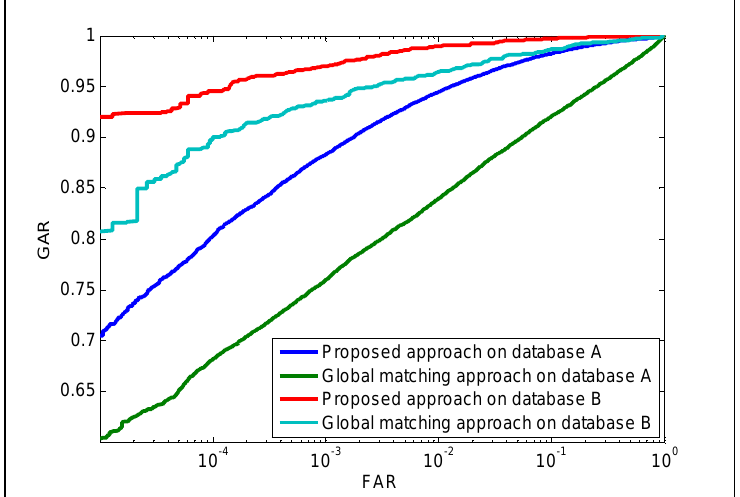
Figure 7. Receiver operating characteristics from two databases for finger-vein shape images with different matching